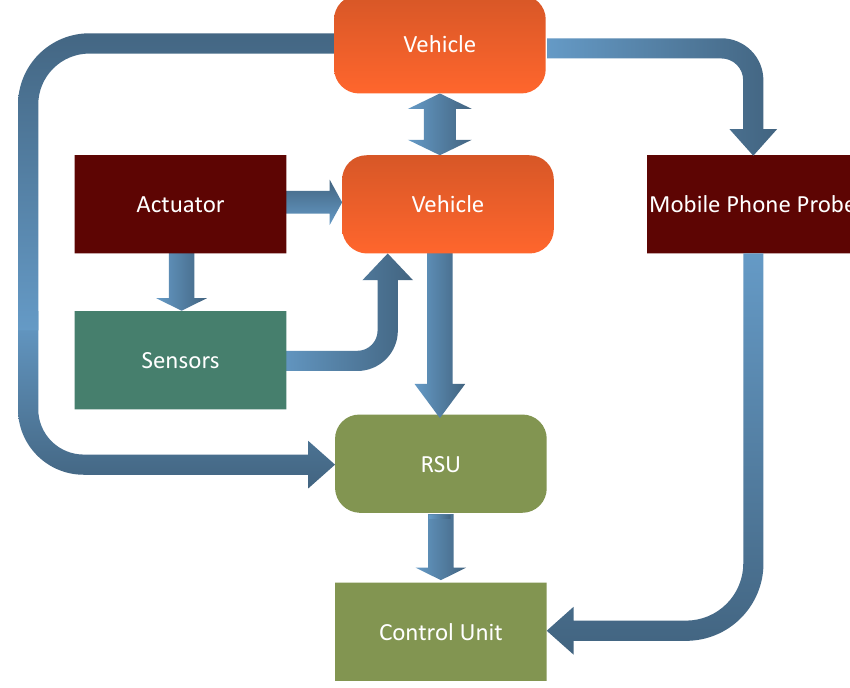
Figure 4. Schematic block diagram of proposed